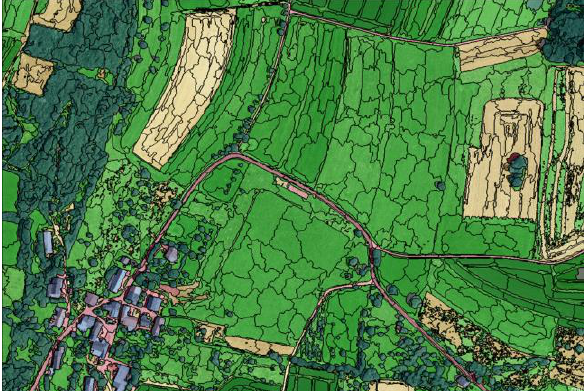
Figure 3: Fine-grained subdivision of the image after threshold-based